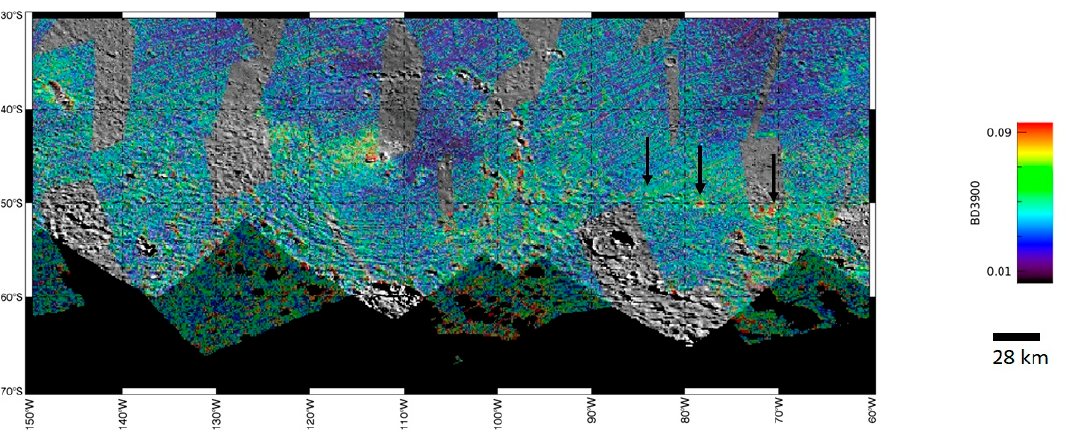
Figure 6. The 3.9 μ m band depth distribution of the Urvara region (3.4 μ m band depth distribution is similar) with arrows indicating carbonate enrichments in correspondence to linear features (cylindrical projection). Scale bar refers to the latitude at the map center.